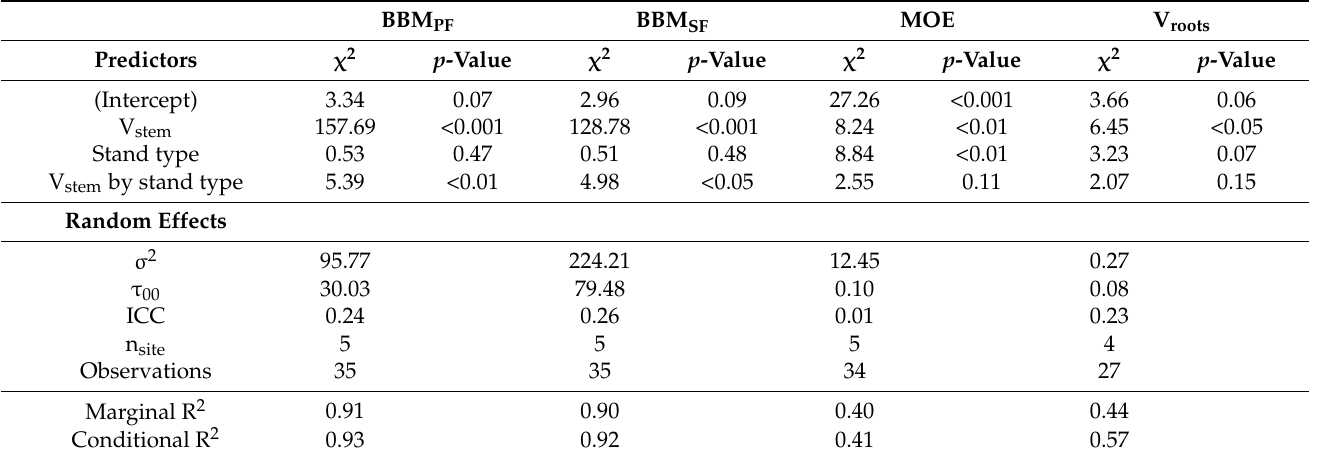
Table 3. Statistics of the linear mixed-effects models characterizing basal bending moment of silver birch at the primary (BBM PF ) and secondary (BBM SF ) failures, modulus of elasticity (MOE), and soil-root plate volume (V roots ) under static